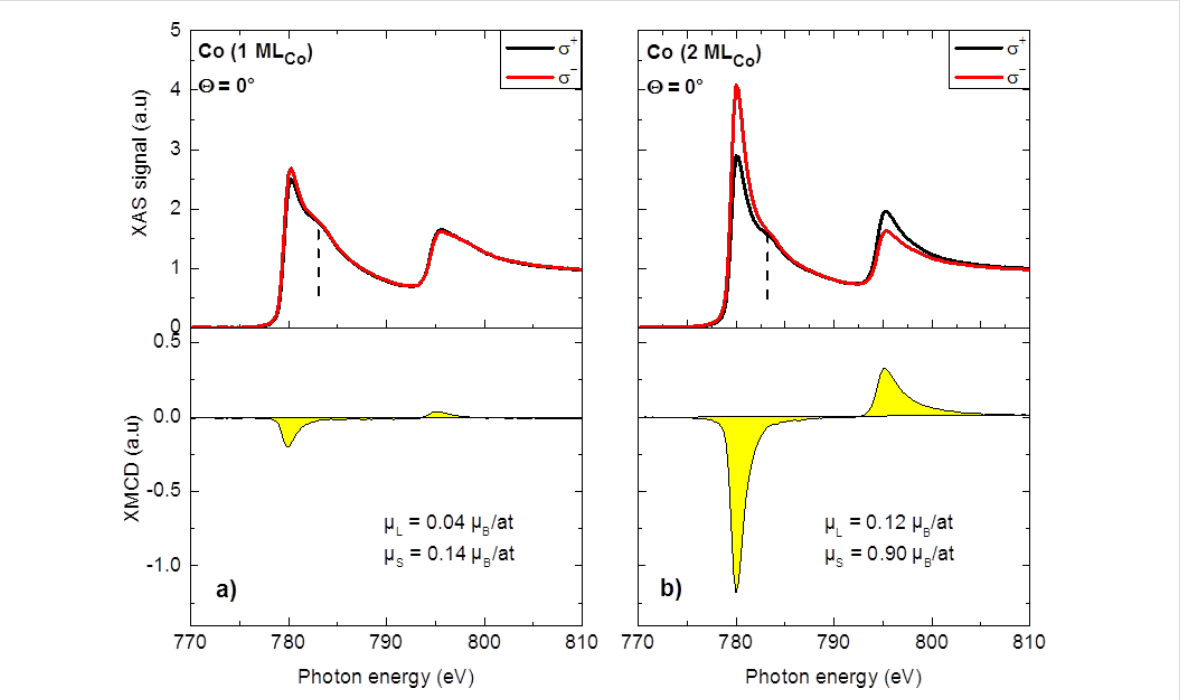
Figure 3: XAS spectra taken at normal incidence ( Θ = 0°) for both helicities ( σ + and σ − ) at 4 K with a magnetic field of 6 T and corresponding XMCD signals for (a) 1 ML Co and (b) 2 ML Co on Si/Ag(110). Orbital and spin magnetic moments in both structures were determined by applying the sum